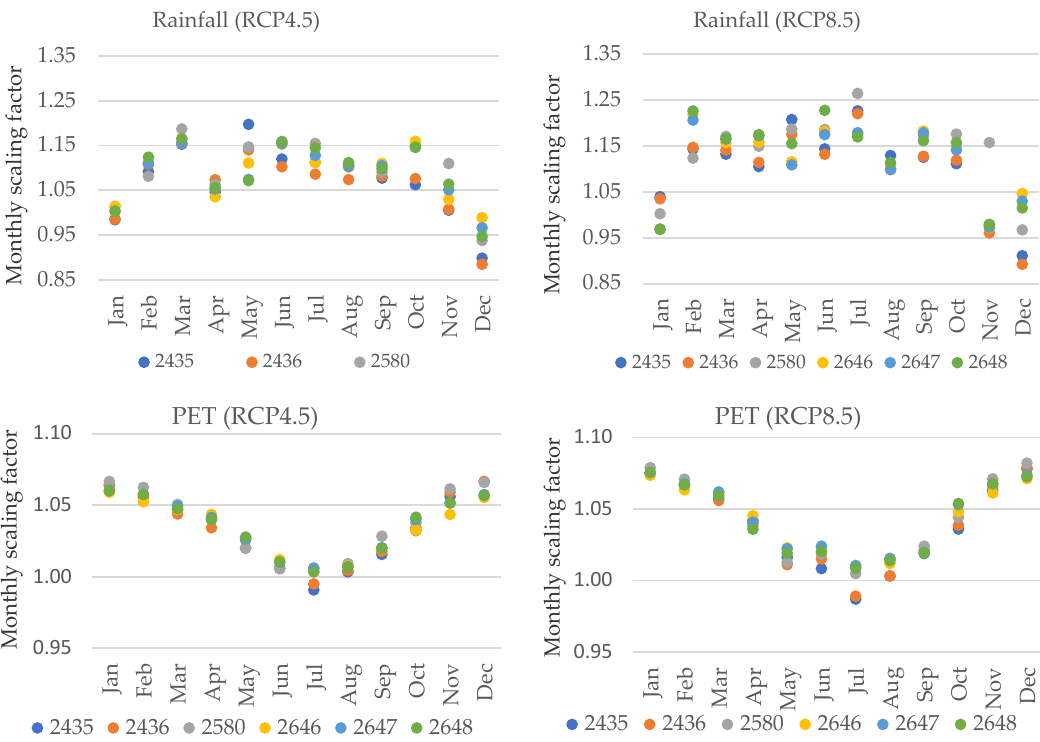
Figure 9. Variations of monthly scaling factor of rainfall (upper panels) and PET (lower panels) across the northwest region for the six GCM grids (refer to Figure 3 for location).